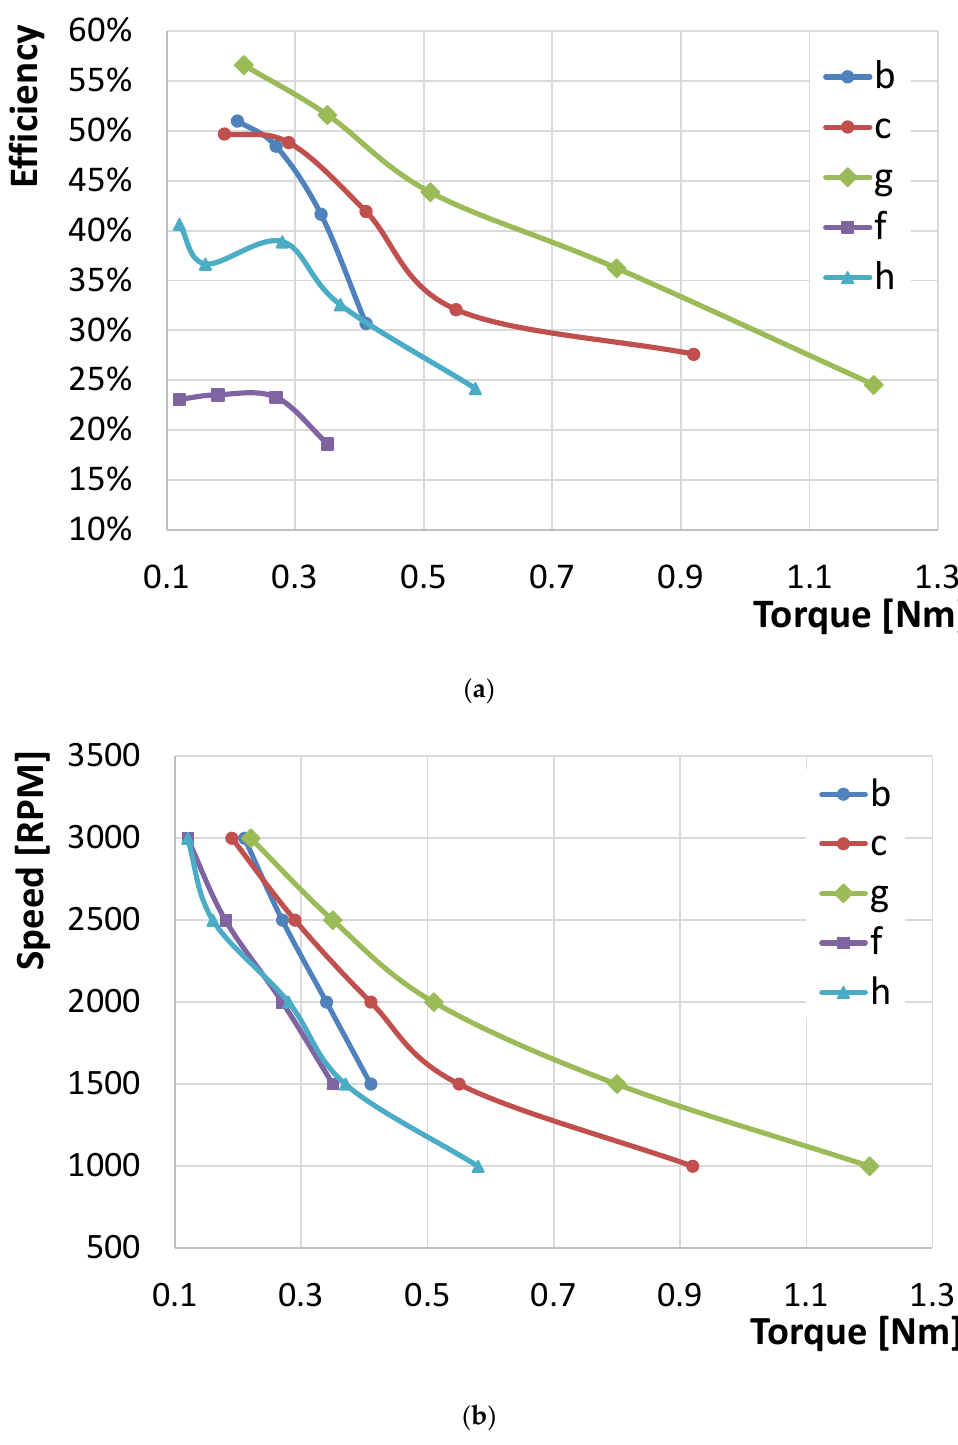
Figure 11. Efficiency ( a ) and speed ( b ) vs. torque dependencies of the winding interconnections defined in Figure 6.